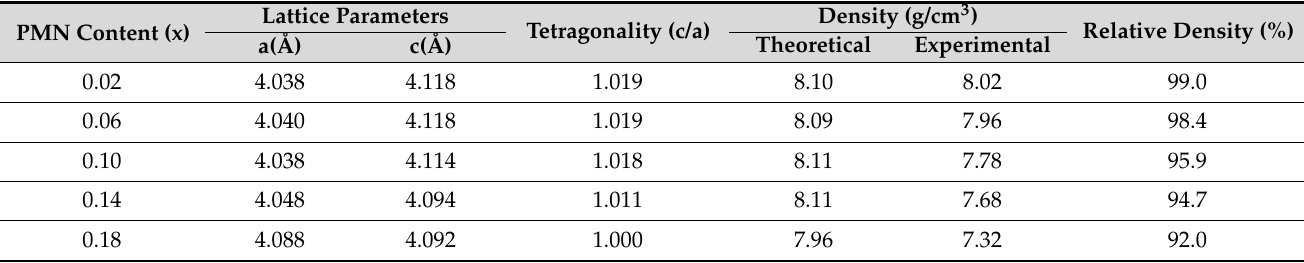
Table 1. Lattice constants, tetragonality and density measurement results according to PMN